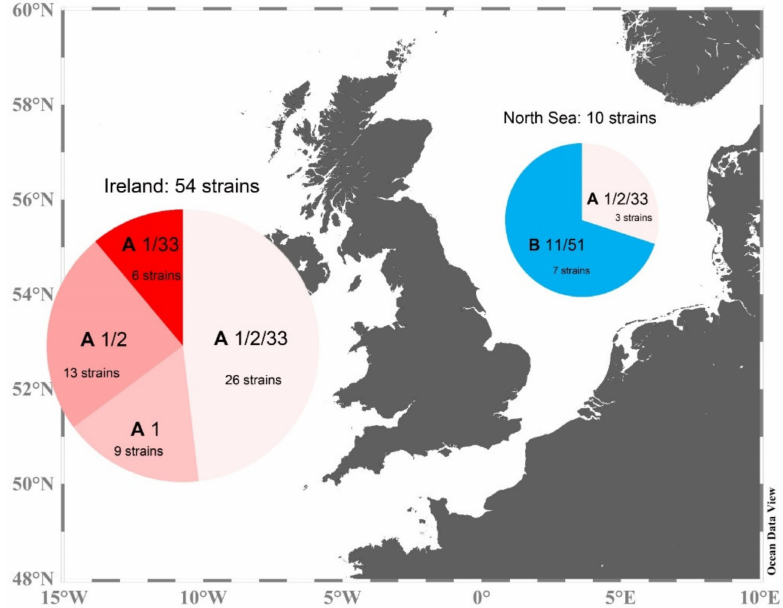
Figure 15. Summary of ribotype ( A , B ), toxin profile (1/2/33; 1/2; 1/33; 1; 11/51) and distribution of newly obtained Az. spinosum